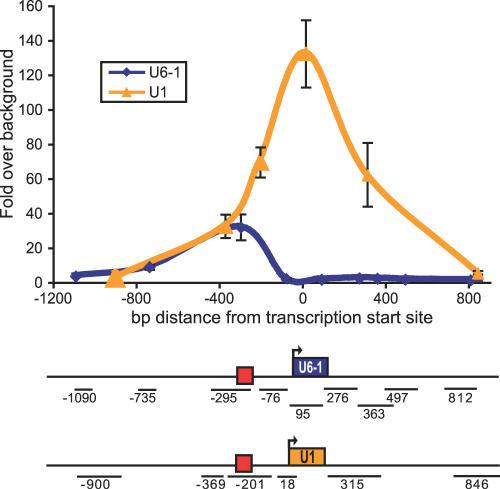
Comparison of Pol II Accumulation Pattern on U6–1 and U1 snRNA GenesChIP with Pol II mAb 4H8 was performed with pemHeLa crosslinked extracts and the purified DNA subjected to qPCR with primers along the U6–1 and U1 snRNA gene regions as shown (Ensembl ID ENSG00000194297 on chromosome 1). Data points represent the center point of the amplified region and Pol II fold accumulation over background and intergenic region, as in Figure 1. Diagrams below the plot indicate the features of both genes, which have been aligned at their respective transcription start sites (arrows). Error bars represent the SEM of at least three independent experiments.